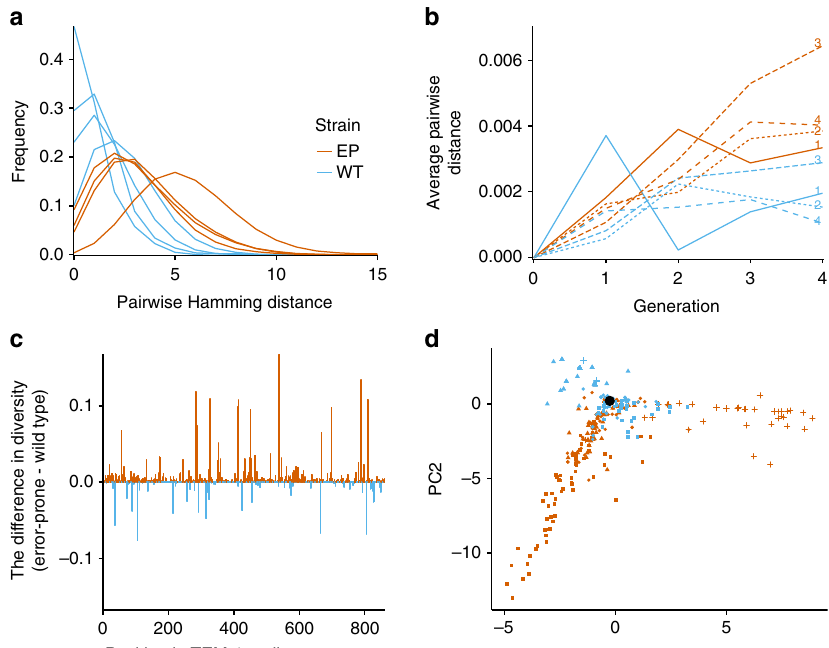
Figure 3 | Genetic diversity is greater in TEM-1 populations evolved in error-prone hosts. ( a ) The distribution of pairwise sequence (Hamming) distances for each of the populations at the end of the experiment (‘generation’ 4). Supplementary Fig. 4a shows the distribution of pairwise sequence distances in all four generations. ( b ) Average pairwise sequence distance (see Methods) within evolved populations. Each line corresponds to the diversity trajectory of one of the evolving populations. Each trajectory is shown with a different line pattern and coloured numbers indicate the replicate population. ( c ) The difference in mean nucleotide diversities along the coding sequence for TEM-1 populations evolved in error-prone and wild-type hosts, from the final (fourth) ‘generation’ of evolution. We used pairwise alignment positional nucleotide counting (PAPNC) (Methods) to calculate the average diversity at each TEM-1 nucleotide site for each evolved population. We calculated diversity at a nucleotide site for a given host as the mean of the diversity values from four replicate populations. We then subtracted the mean diversity of the wild-type host from the mean diversity of error-prone hosts, such that values above the horizontal axis (red) correspond to nucleotide sites with higher diversity in error-prone populations. Monomorphic positions are omitted from the plot. ( d ) The distribution of evolved DNA sequences in sequence space. We randomly sampled 200 sequences without replacement from all populations after the fourth generation of evolution, aligned them and then projected the aligned sequences onto two-dimensional space using principal component analysis. The figure shows the first two principal components (PC1 and PC2, explaining 5.3 and 4.6% variability, respectively, see also Supplementary Fig. 6). Each symbol shape corresponds to a sequence, colours correspond to hosts (red ¼ error-prone, blue ¼ wild-type) and different shapes correspond to different replicate populations. The black circle corresponds to the ancestral TEM-1